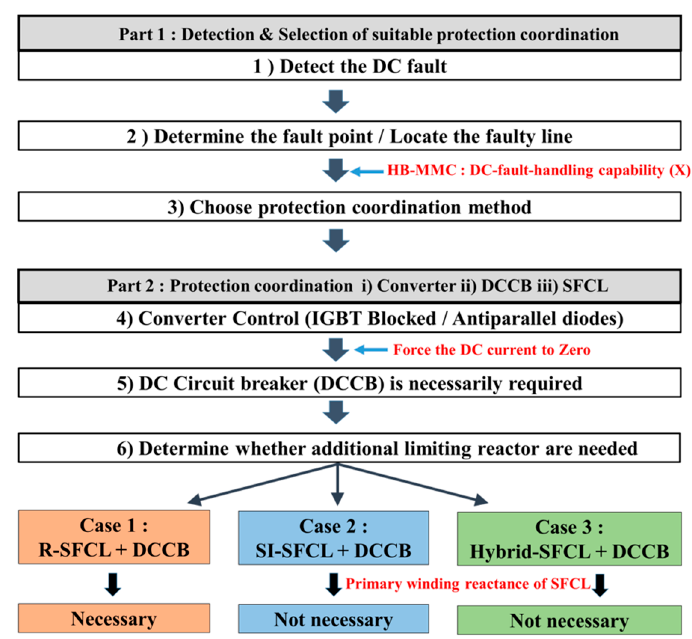
Figure 2. Comparison of overall operating characteristics and the need for an additional current limiting reactor.